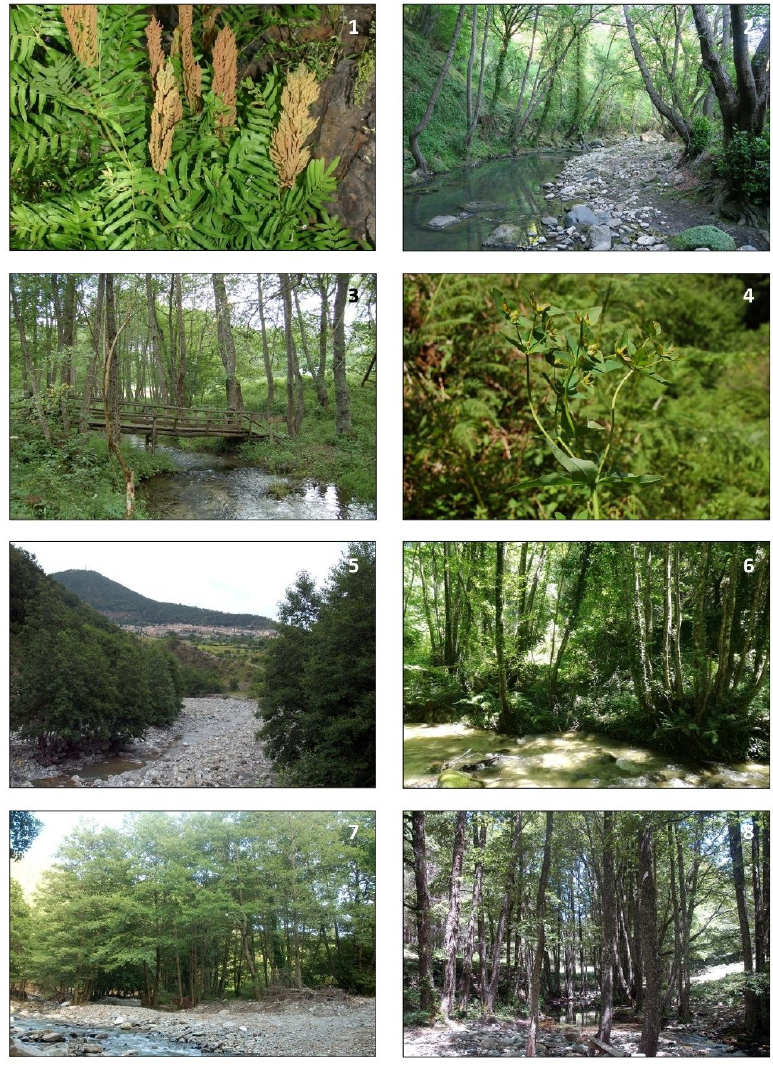
Figure 7. Plant communities and diagnostic species of the Alnus glutinosa riparian woodlands in Italian Peninsula: ( 1 ) Osmunda regalis, in the Carici pallescentis-Alnetum glutinosae (Toscana); ( 2 ) Carpino betuli-Alnetum glutinosae (Mignone, Canale Monterano—Lazio); ( 3 , 4 ) Euphorbio-Alnetum glutinosae , respectively, in Sila Grande and Torrente Vasi (Calabria); ( 5 ) Euphorbia corallioides , characteristic species of the Euphorbio-Alnetum glutinosae (Calabria); ( 6 ) Angelico sylvestris-Alnetum glutinosae (Torrente Sarmento, Pollino Mounts—Calabria); ( 7 , 8 ) Polysticho-Alnetum glutinosae , respectively, in the Serre Calabre and Torrente Ferraino (Aspromonte—Calabria); Photo credits: O. Caldarella ( 1 ), M. Cutini ( 2 ), G. Spampinato ( 3 ), L. Gianguzzi ( 4 , 5 , 7 , 8